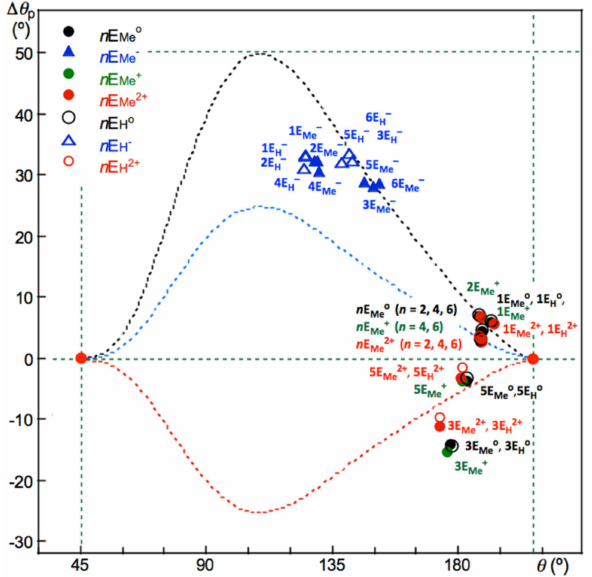
Figure 6. Plots of ∆ θ p versus θ for E- ∗ -E’ in [REE’R]* (R = Me and H: * = null, − , +, and 2+), evaluated with MP2/BSS-C. The species numbers are shown in Table 2. Red circles correspond to the θ period of 45.0 ◦ ≤ θ ≤ 206.6 ◦ and green horizontal lines are for ∆ θ p = 0 ◦ and 50.0 ◦ .